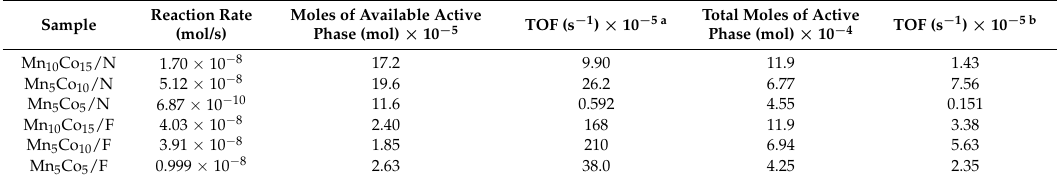
Figure 8. Stability tests results of Mn 10 Co 15 /N and Mn 10 Co 15 /F at 185 °C. Table 4. Comparison of the turnover frequencies (TOFs) for the oxidation of benzene at 125 °C.